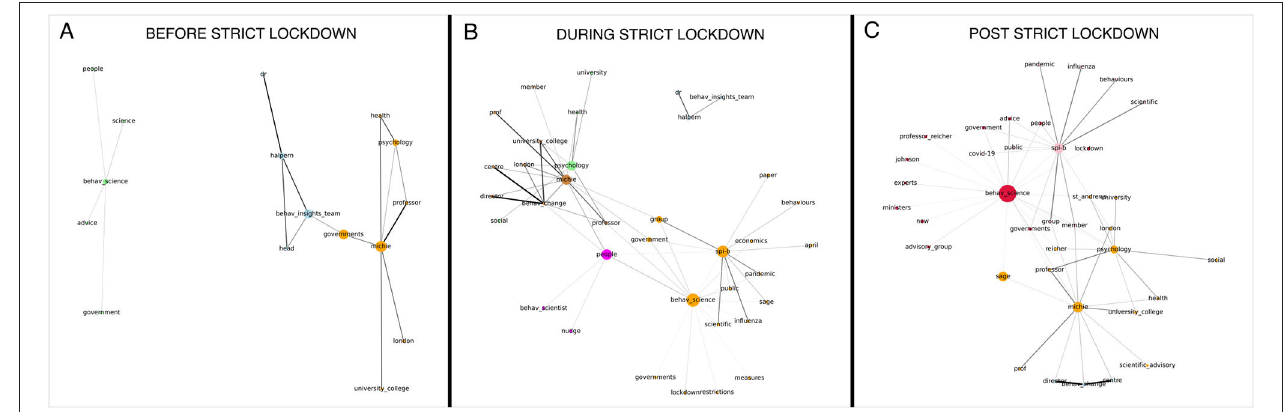
FIGURE 7 | Networks of keyword co-occurrence across the three time periods: pre-lockdown (A) , during lockdown (B) , and post-strict lockdown (C) . Each node represents a keyword. Edgelines represents the strength of the co-occurrence (Dice coefficient) between two keywords. The node size represents the keyword’s weighted betweenness centrality (a small constant has been added to all nodes so that all could be visible in the graph). Nodes are colored according to their community, as detected by the Louvain modularity algorithm.